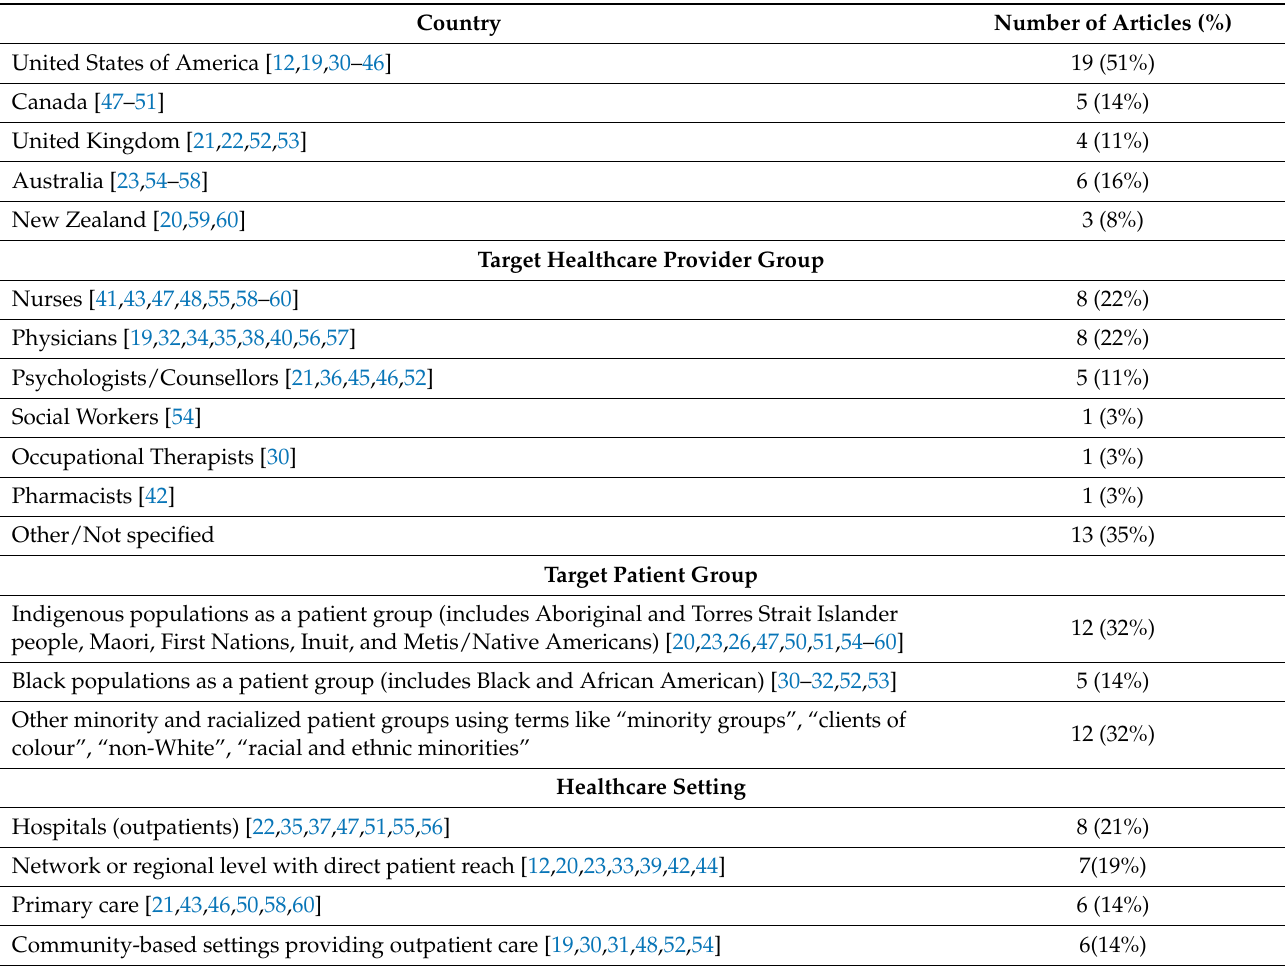
Table 1. Summary of results from peer-reviewed literature ( n = 37) .